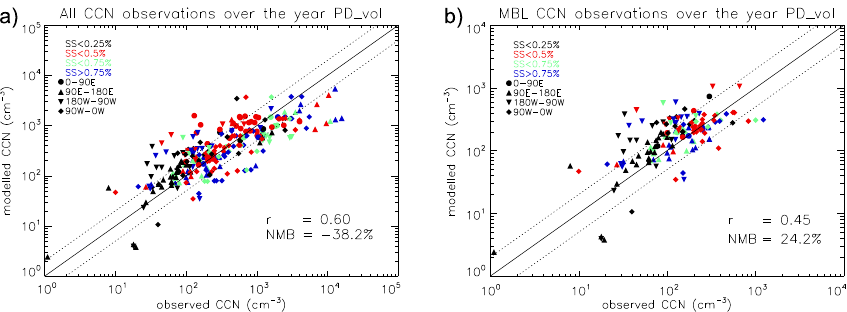
Fig. 3. Observed versus modelled cloud condensation nuclei (CCN) number concentrations with (a) model evaluation using the present-day (PD) simulation including volcanic emissions against all CCN observations over the year; and (b) evaluation of the PD simulation that includes volcanic emissions against marine boundary layer (MBL) CCN observations only. The solid line represents the 1:1 relationship and the dotted lines show the 1:2 and 2:1 relationships. The colours indicate the supersaturation and the symbols indicate the region of the modelled/observed CCN as shown in the plots’ keys. The Pearson’s correlation coefficient is stated as r , and the normalised mean bias (NMB, in %) is calculated as follows: NMB = 100% × P (M i − O i )/ P O i where M i refers to the modelled CCN concentration and O i to the observed CCN concentration. For the comparison both the month and the supersaturation of each CCN measurement was taken into account using the method and observational CCN dataset described and compiled by Spracklen et al.